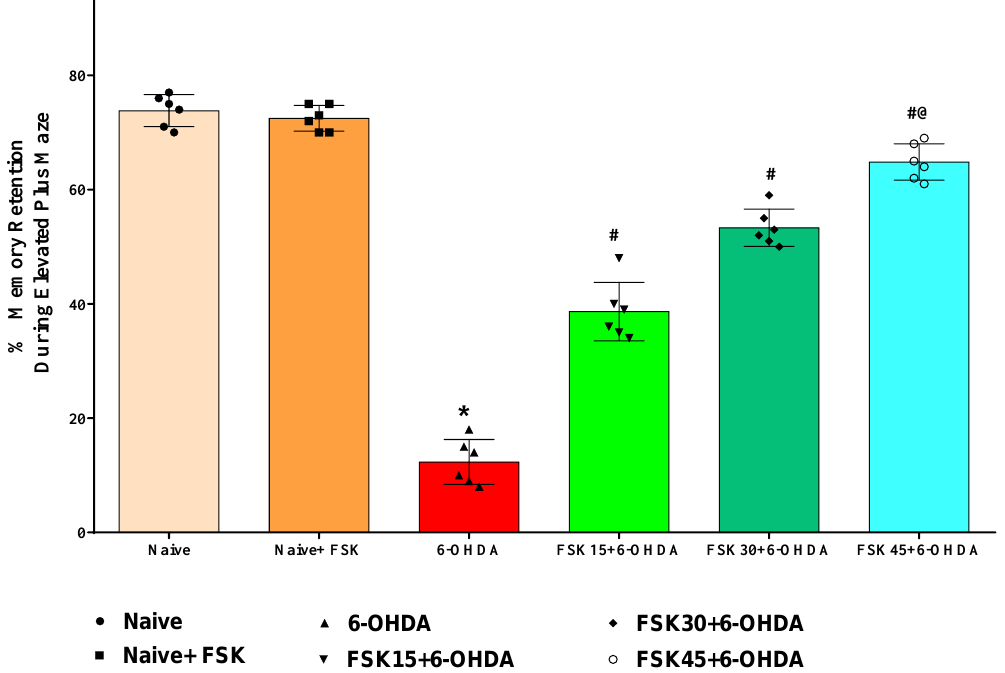
Figure 2. FSK mediated muscle grip restoration using the grip strength task in the experimental model of PD. Data provided as mean ± SD (n = 6 ) followed by ANOVA (two-way) with post-hoc Bonferroni test. * 6-OHDA ( p < 0.01) compared with naive and naive + FSK ; # FSK15, FSK30, FSK45 (p < 0.01 ) compared with 6-OHDA ; #@ FSK45 (p < 0.01 ) compared with FSK30, FSK15 .